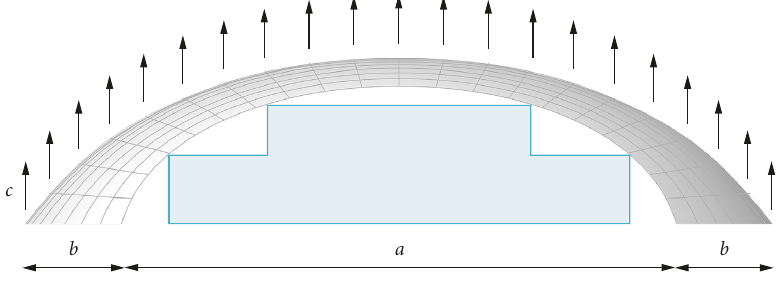
Figure 11: Structural gauge of the railway track to be enclosed.